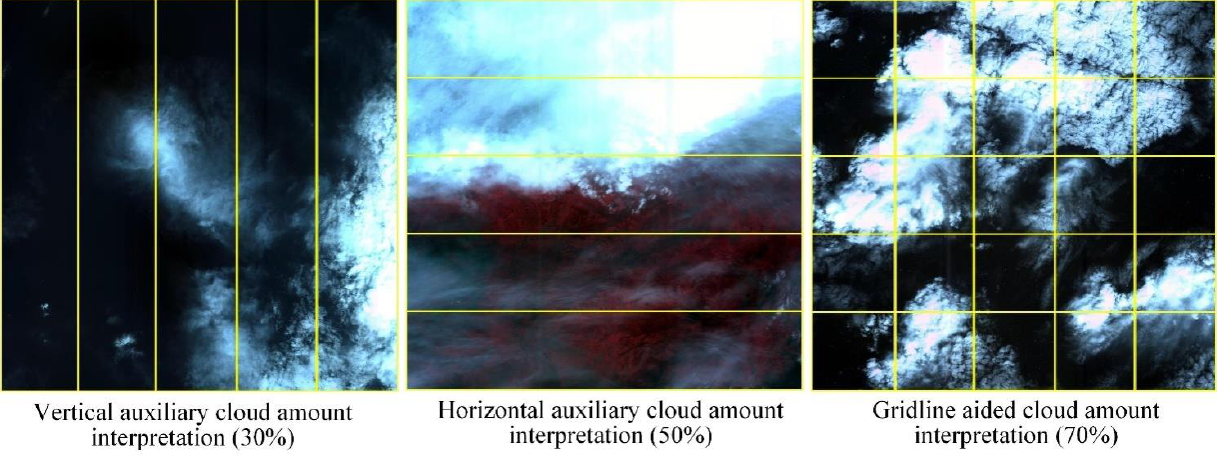
Figure 6. Schematic diagram of grid cloud-amount calculation.